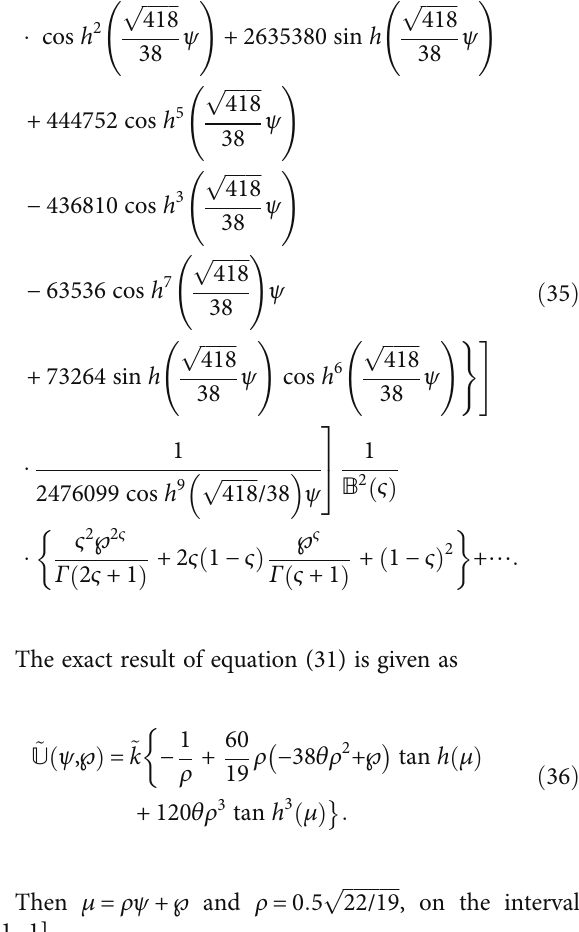
Figure 3 represents the two-dimensional upper and lower fuzzy branch plots of the approximate series result and di ff erent fractional order of ς . Figure 4 represents the two-dimensional upper and lower fuzzy branch plots with respect to time.